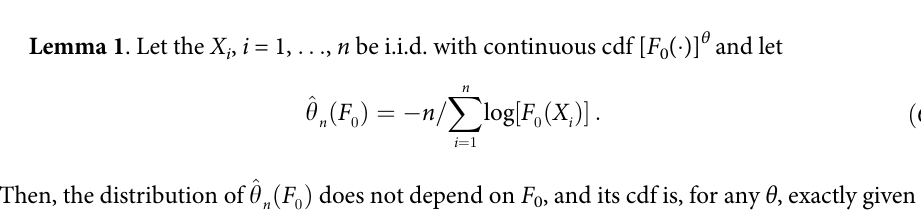
Fig 1. Region of univariate cdf’s being equivalent to F (solid line) in the sense of not exceeding a maximal vertical distance of δ = 0.15 from the model to be established.